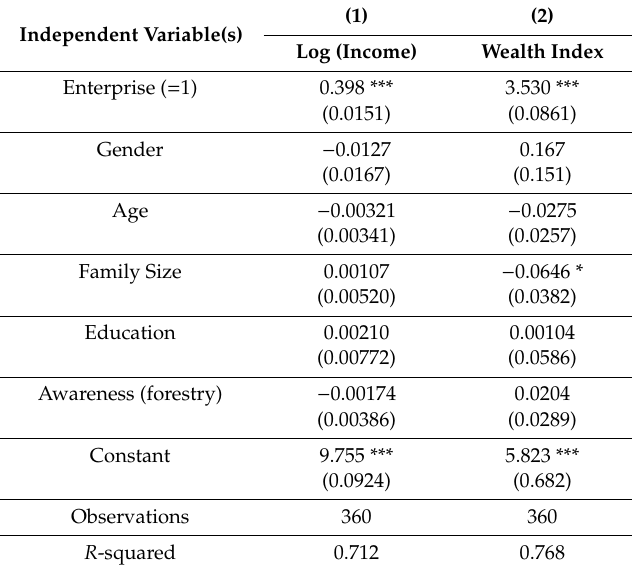
Table 3. BTAP and observed